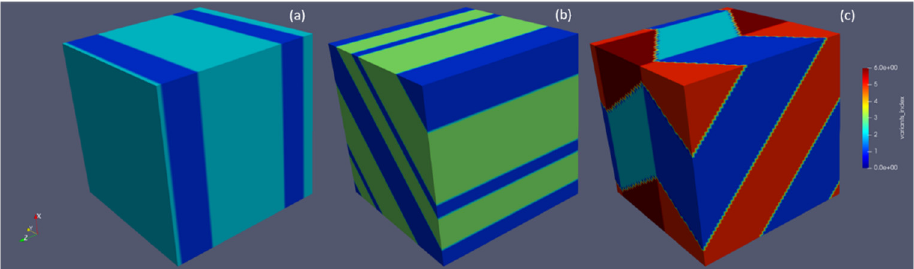
Figure 4. Twinned microstructure with different variant combinations: ( a ) compound twin; ( b ) Type I twin and ( c ) Type II twin.